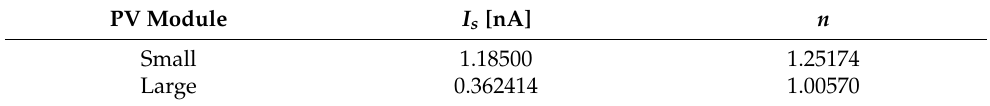
Table 8. Forward bias ( D f ) large-signal DC parameters for the two PV modules.